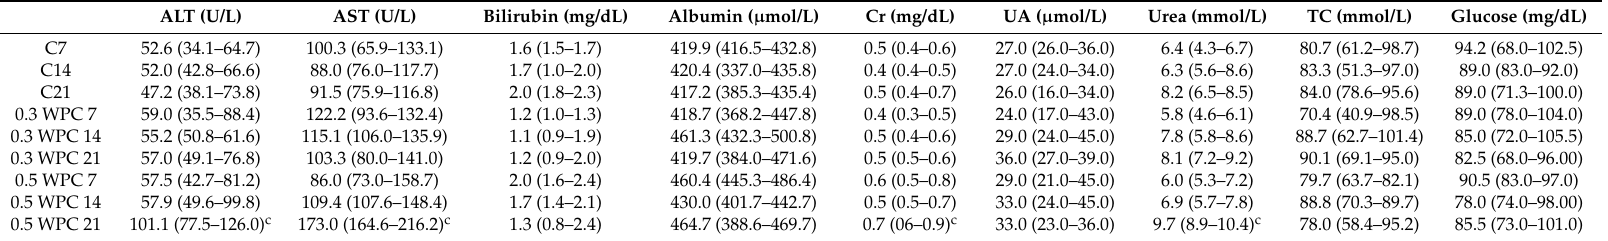
Table 3. Serum and plasma biochemical parameters in rats fed with WPC-80 and the controls [median